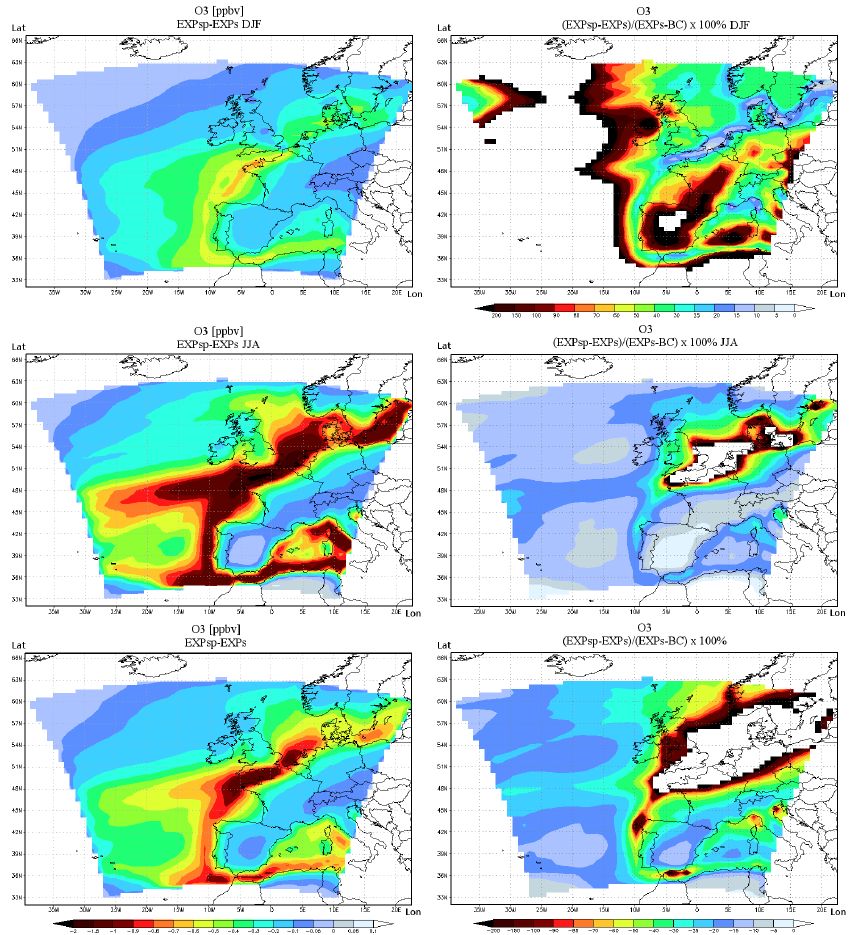
Fig. 8. Left column: difference of surface O 3 between EXPsp and EXPs in ppbv for winter (top), summer (middle) and as annual average (bottom). Right column, middle and bottom: reduction of ship ozone perturbation due to plume effects as (EXPsp-EXPs)/(EXPs-BC) × 100% for summer and as annual average. Areas skipped (in white) represent regions where ship emissions cause ozone depletion. Top right figure: enhancement of ship induced O 3 destruction applying ship plume parameterization as (EXPsp-EXPs)/(EXPs-BC) ×